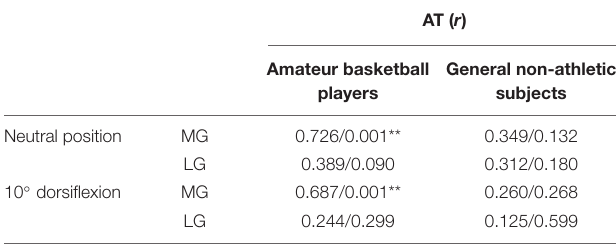
TABLE 4 | The relationship of the stiffness between the AT and MG and